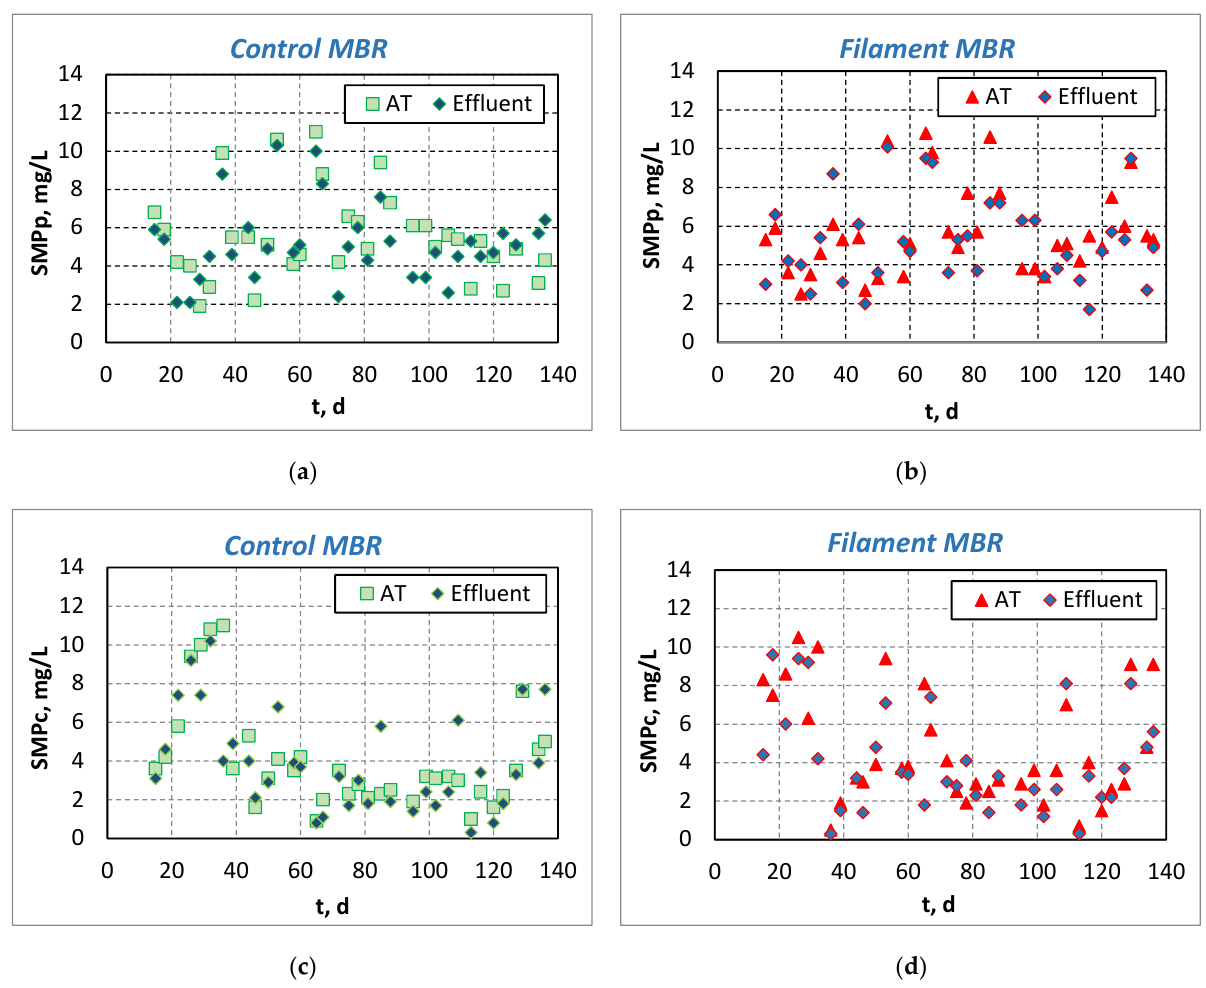
Figure 3. Evolution of protein and carbohydrate fraction of SMP (SMP p and SMP c , respectively) in the aeration tank (AT) and in the effluent of the pilot-scale MBR: ( a ) SMP p in the Control-MBR, ( b ) SMP p in the Filament-MBR, ( c ) SMP c in the Control-MBR and ( d ) SMP c in the Filament-MBR.